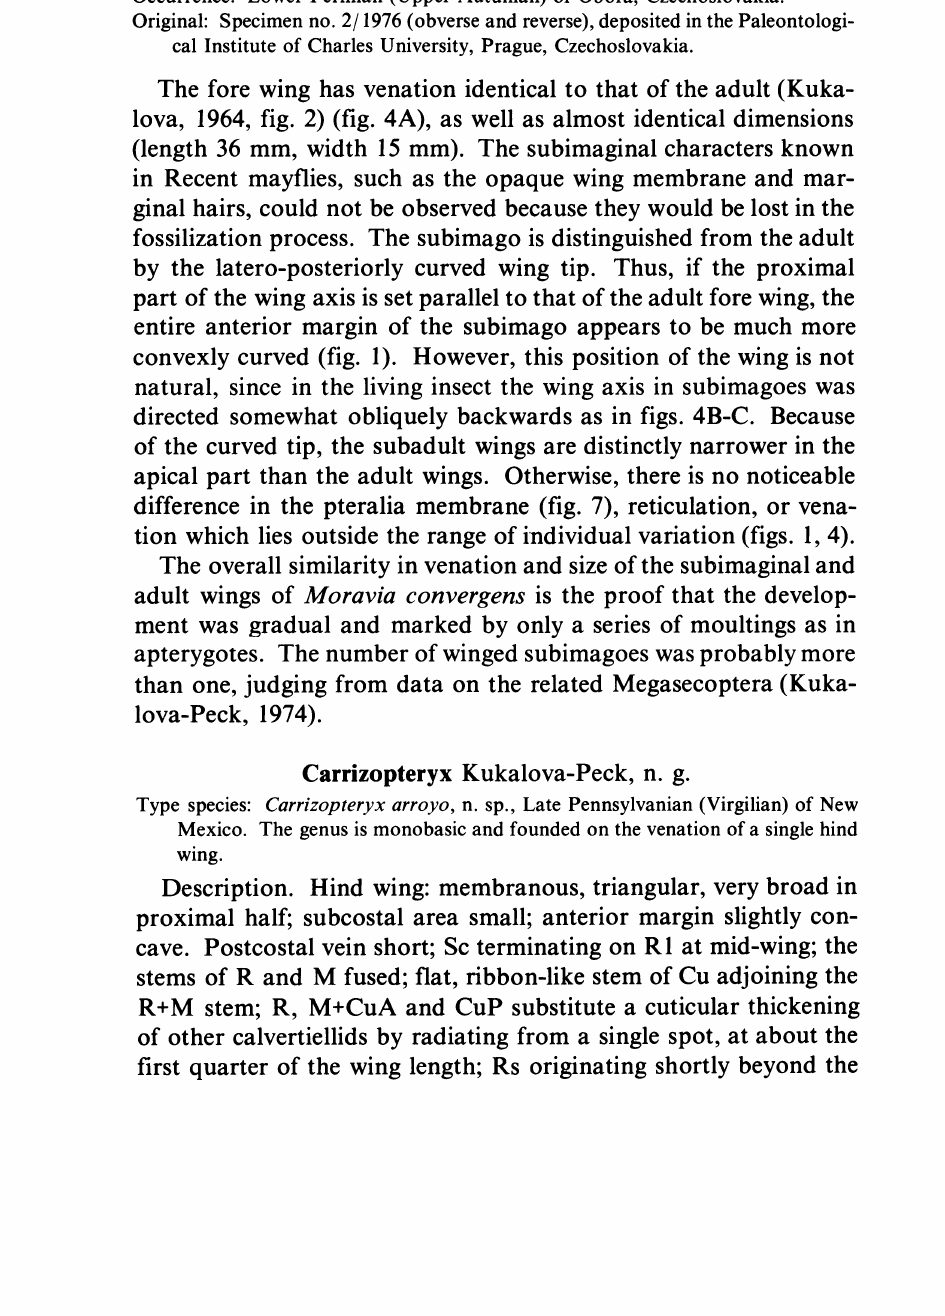
Moravia convergens Kukalova, subimago Figs. 1, 4B, 7 Occurrence: Lower Permian (Upper Autunian) of Obora,